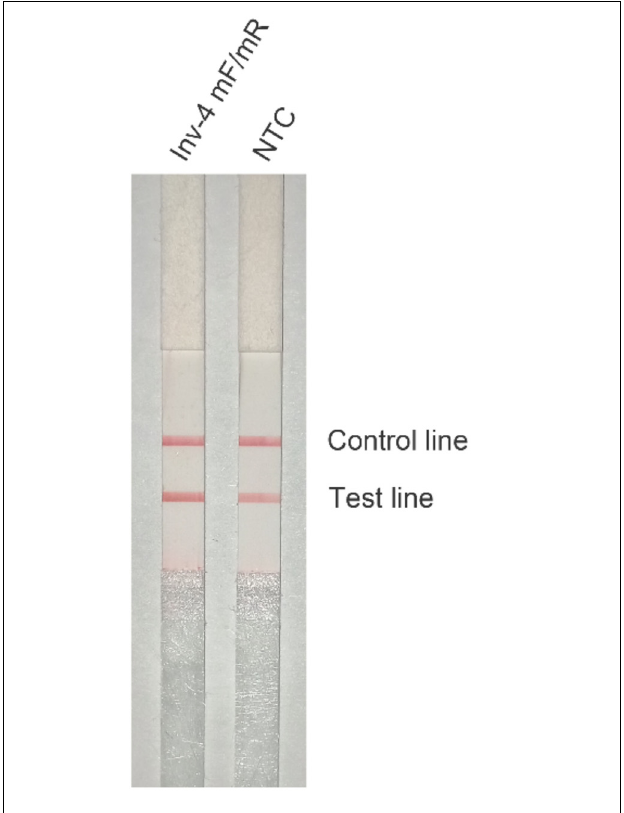
FIGURE 3 | Test of the primer pair Inv-4 on RPA–LFS. The primer pair Inv-4 is labeled with fluorescein isothiocyanate (FITC) and biotin for RPA–LFS detection. The NTC lane is the no-template control. The original primer pair Inv-4 gives false-positive signals on the RPA–LFS system. The test lines and control lines are marked on the right side of the picture. The reactions were performed at 37 ◦ C for 30